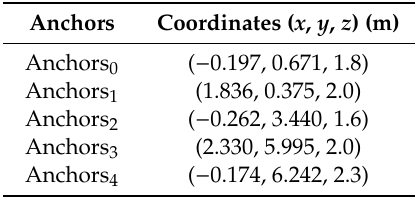
Table 1. Coordinates of anchors.